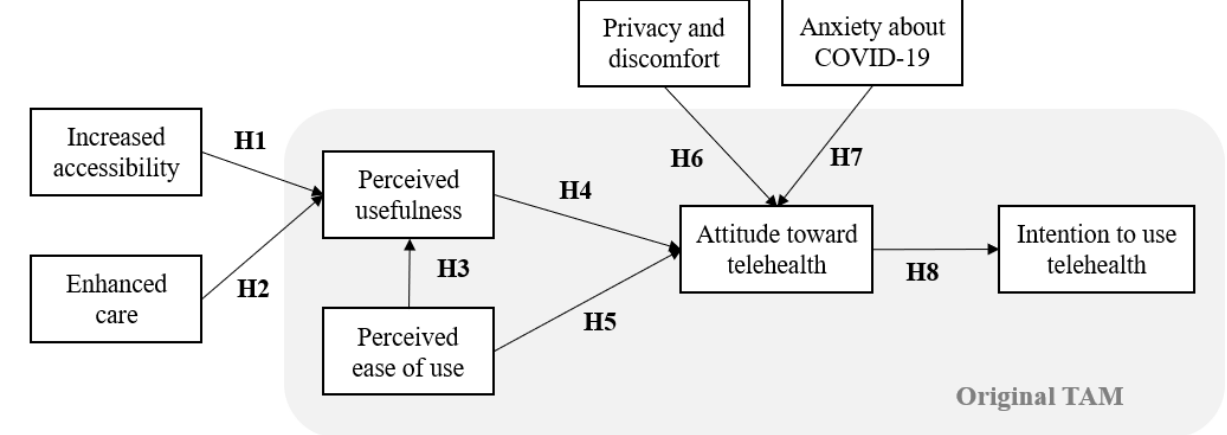
Figure 1. Research model. TAM: technology acceptance